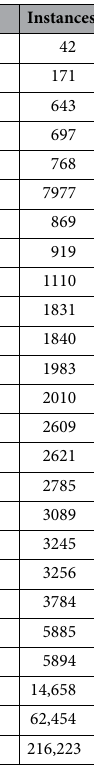
Table 6. Number of instances in each class of virus.